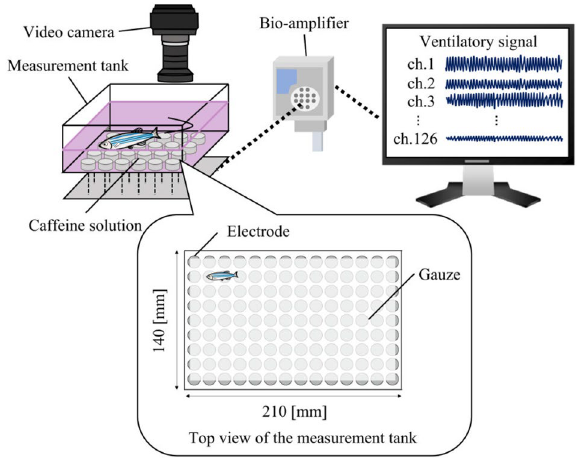
Figure 5. Measurement equipment for experiment under free-swimming conditions.